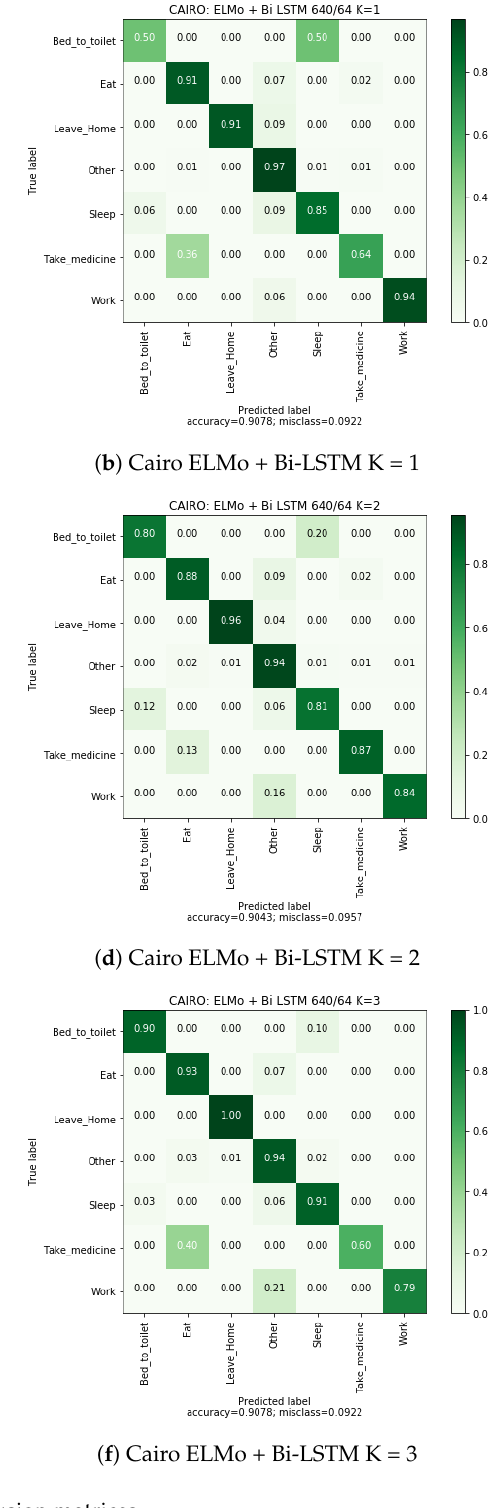
Figure A3. Cairo confusion